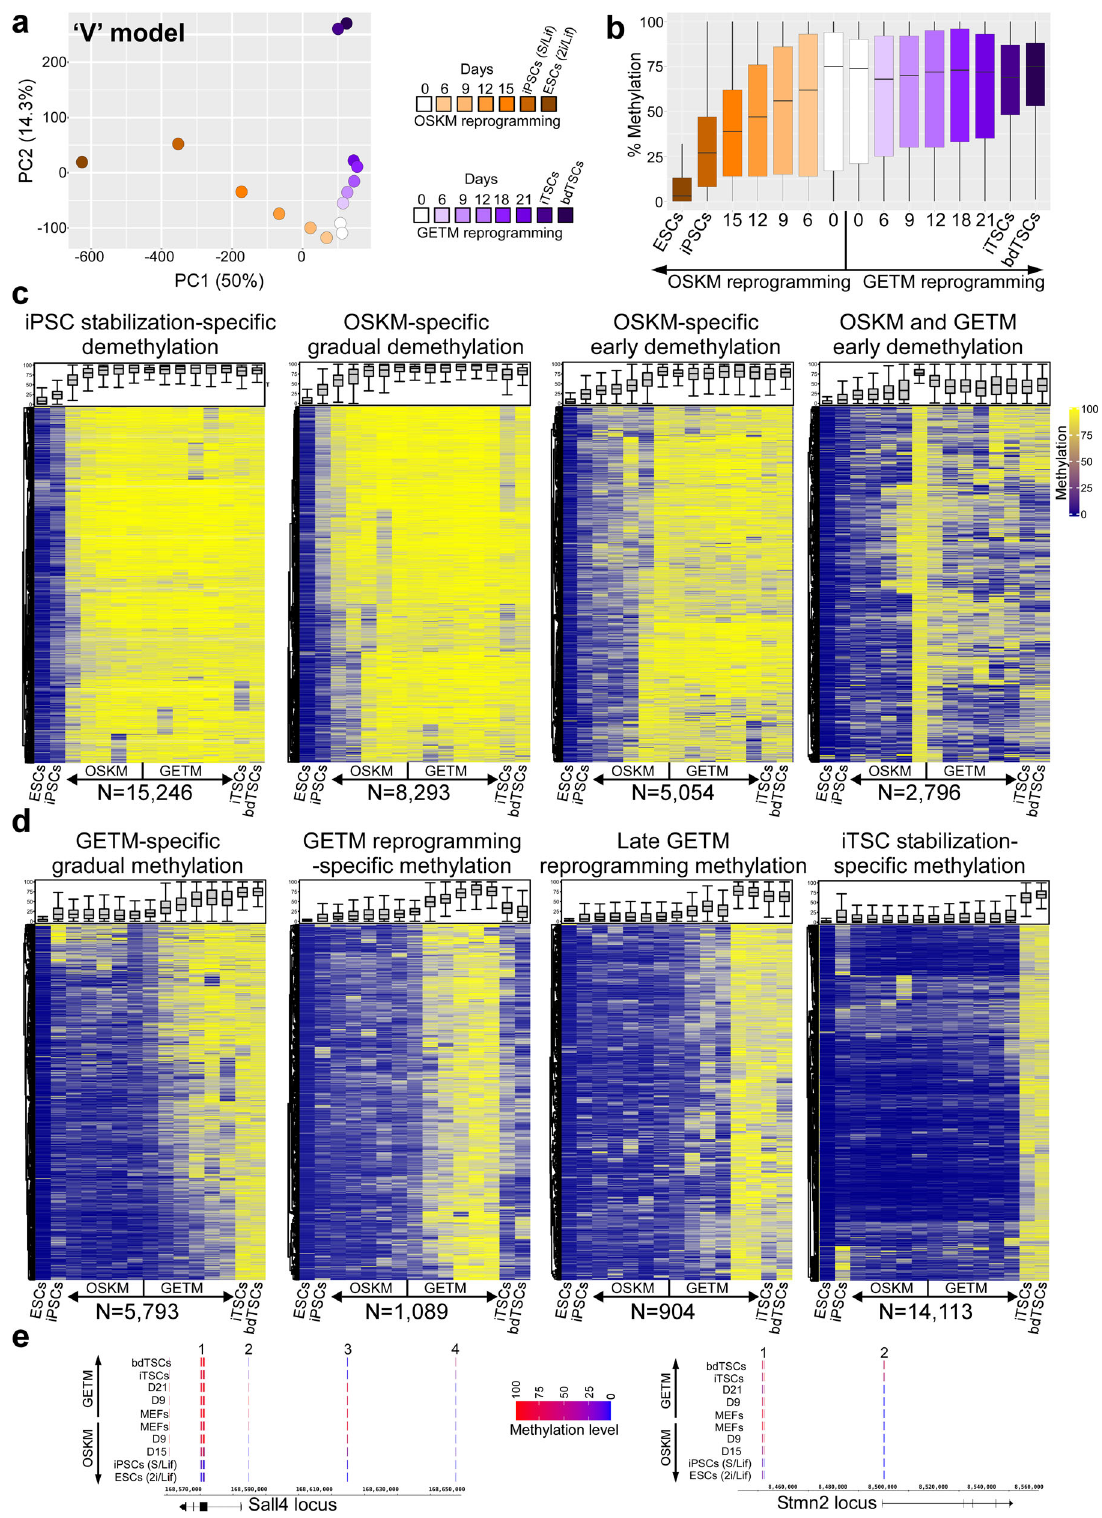
reprogramming process are mostly localized to introns and intergenic regions (Fig. 5d and f). EnrichR GO analysis on the genes associated with the shared open promoters suggested that many of these active promoters are associated with response to the lentiviral infection itself ( p ≤ 0.001). No signi fi cant differences in the distribution of H3K27ac was found between the various samples. These data suggest that the